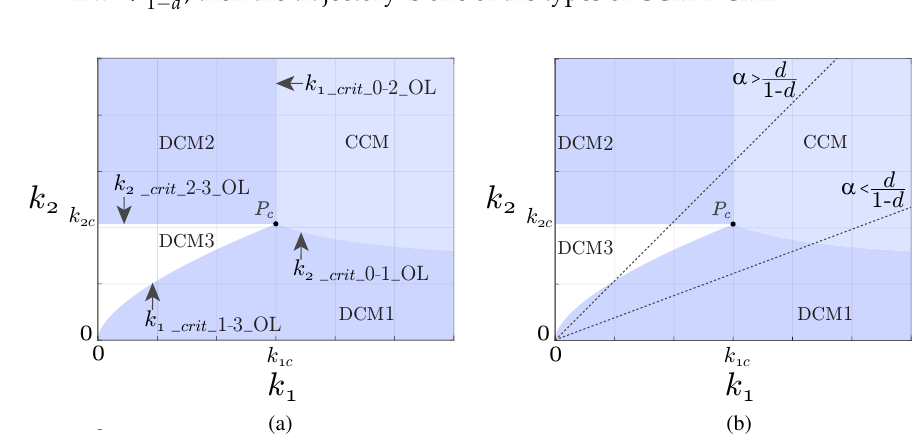
Figure 4. ( a ) Map of conduction regions in an open loop, ( b ) possible